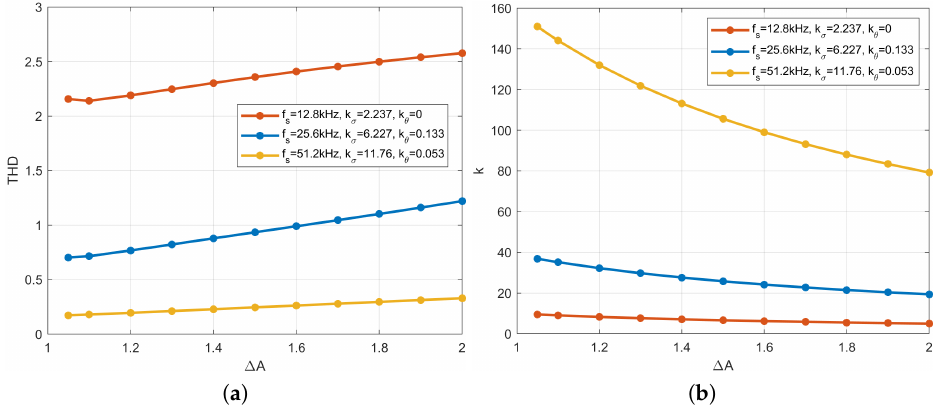
Figure 6. Dependence of ( a ) THD and ( b ) loop gain k from the gain margin ∆ A for various sampling frequencies f s . High frequencies f s enable big values of k leading to small values of